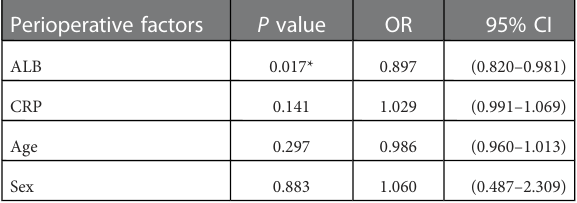
TABLE 6 Multivariable analysis of independent risk factors for acute SSI after